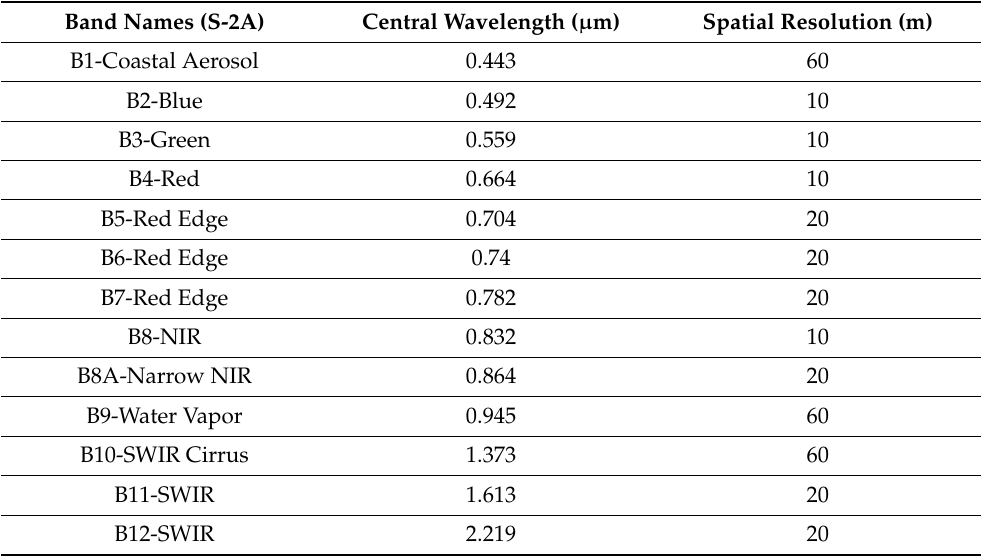
Table 5. Spectral bands of Sentinel-2A sensors and their wavelength and spatial